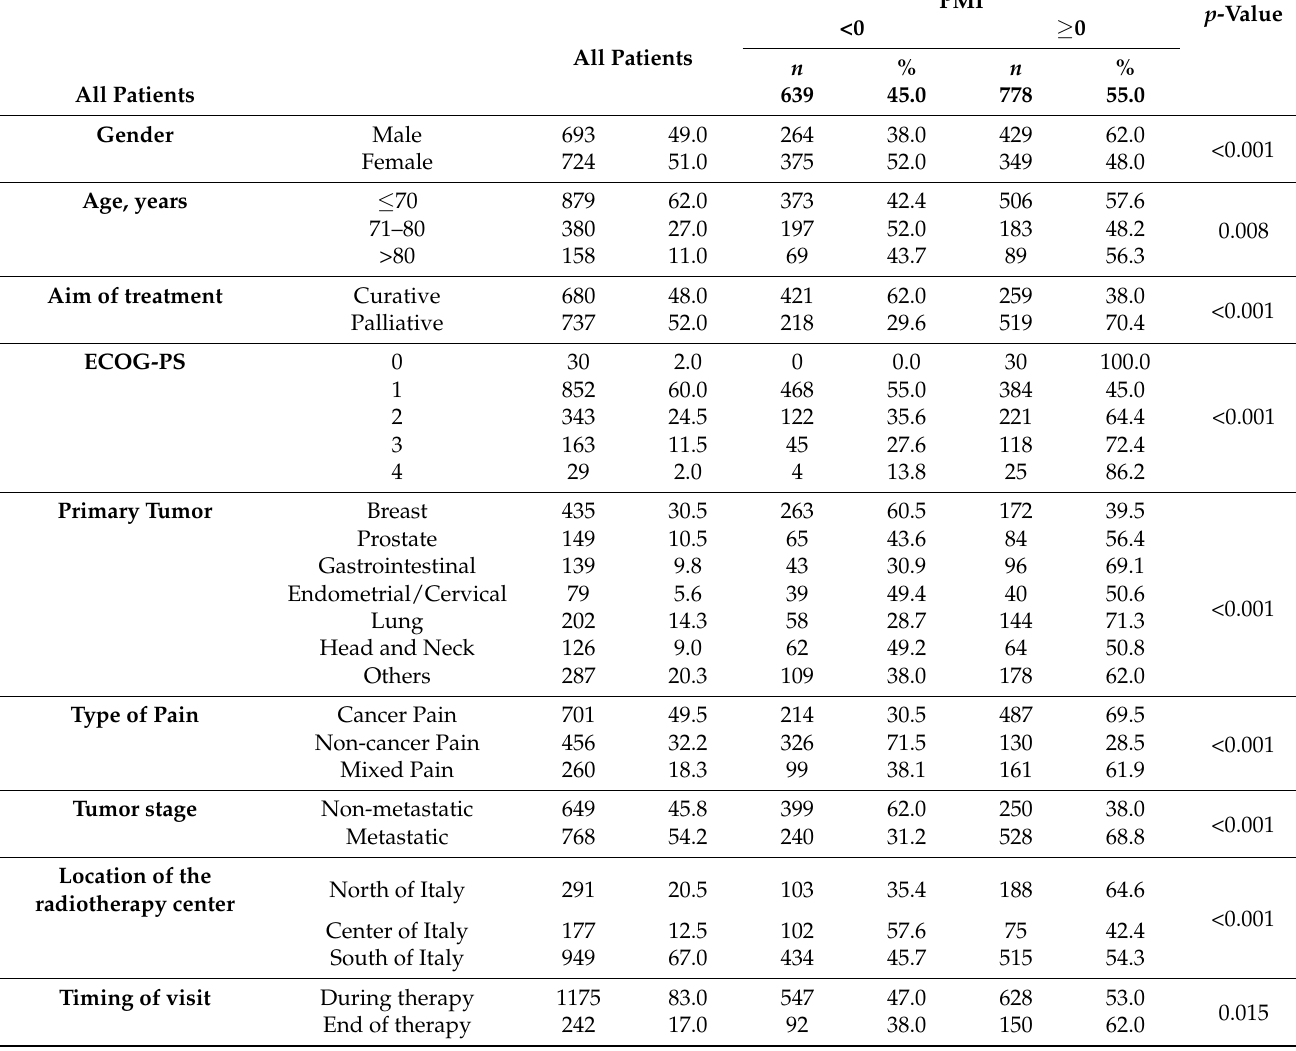
Table 2. Univariate analysis on Pain Management Index (only 1417 patients with pain or under analgesic therapy